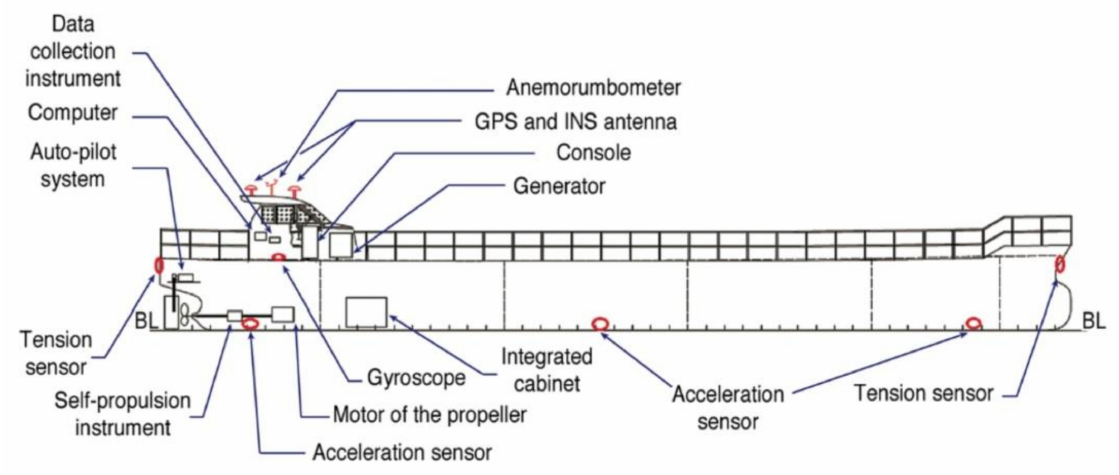
Figure 8. Ship layout with sensor arrangements